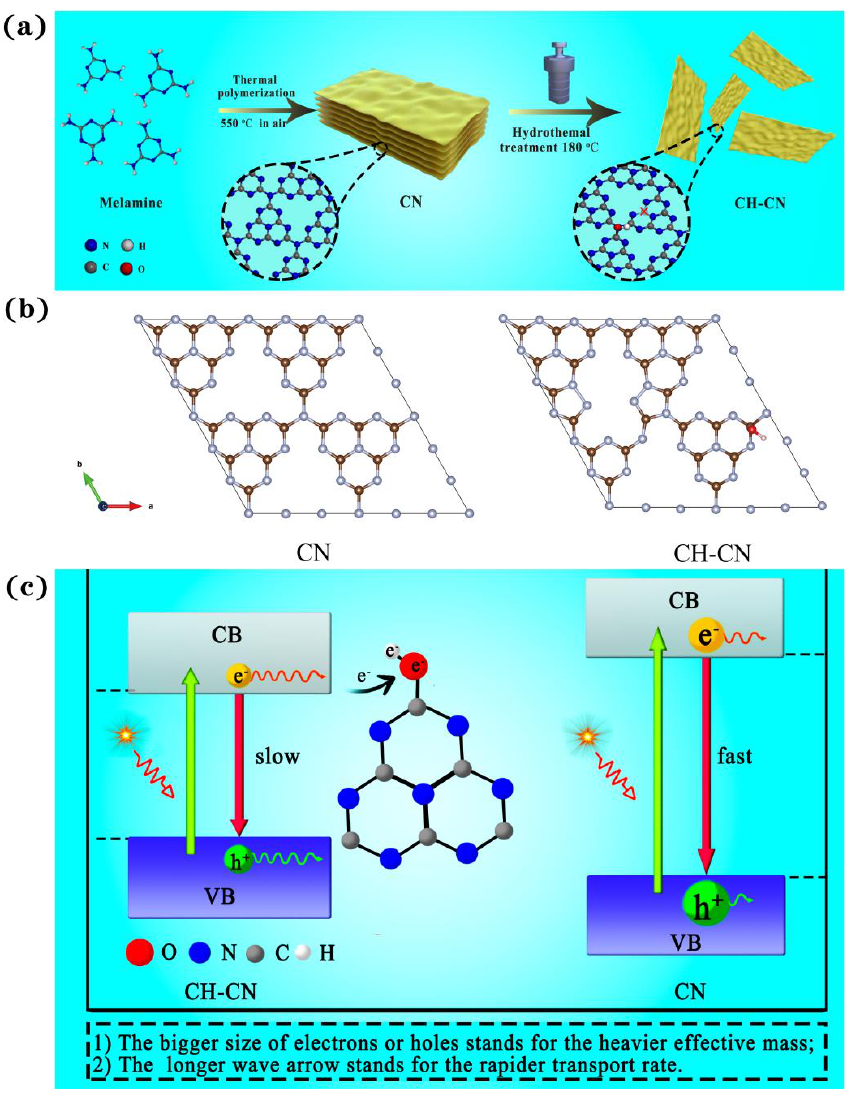
Figure 11. ( a ) Schematic illustration for the preparation of carbon vacancies and hydroxyls co − mod- ified g − C 3 N 4 . ( b ) Schematic illustration for the g − C 3 N 4 and carbon vacancies and hydroxyls co − mod- ified g − C 3 N 4 . ( c ) The proposed mechanism of carbon vacancies and hydroxyls co − modified g − C 3 N 4 for improved photocatalytic performance of g − C 3 N 4 [111]. Copyright 2020, Elsevier. improved photocatalytic performance of g − C 3 N 4 [111]. Copyright 2020,